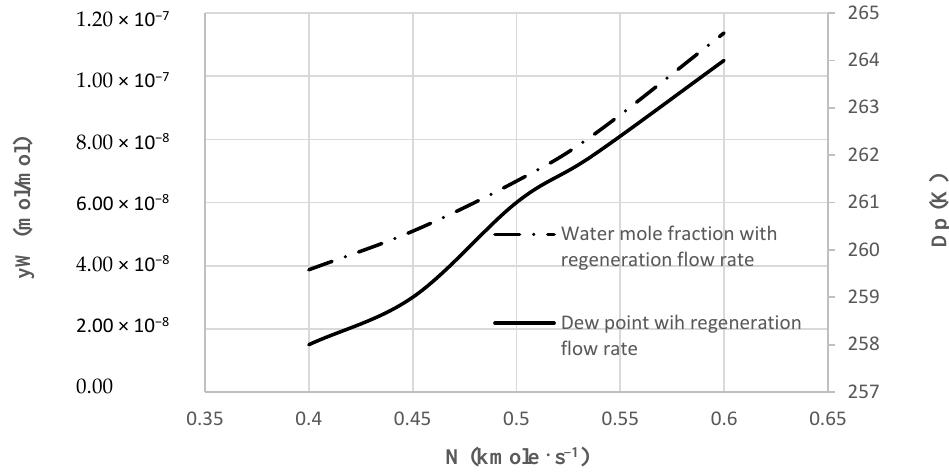
Figure 21. Relationship of water mole fraction and hydrocarbon dew point versus gas regeneration mass flux.